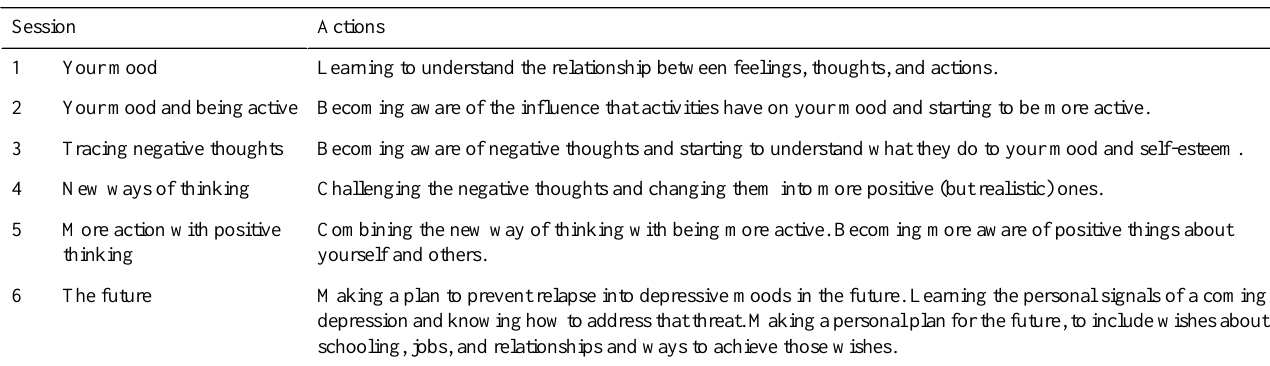
Table 1. Outline of the online course Master Your Mood.